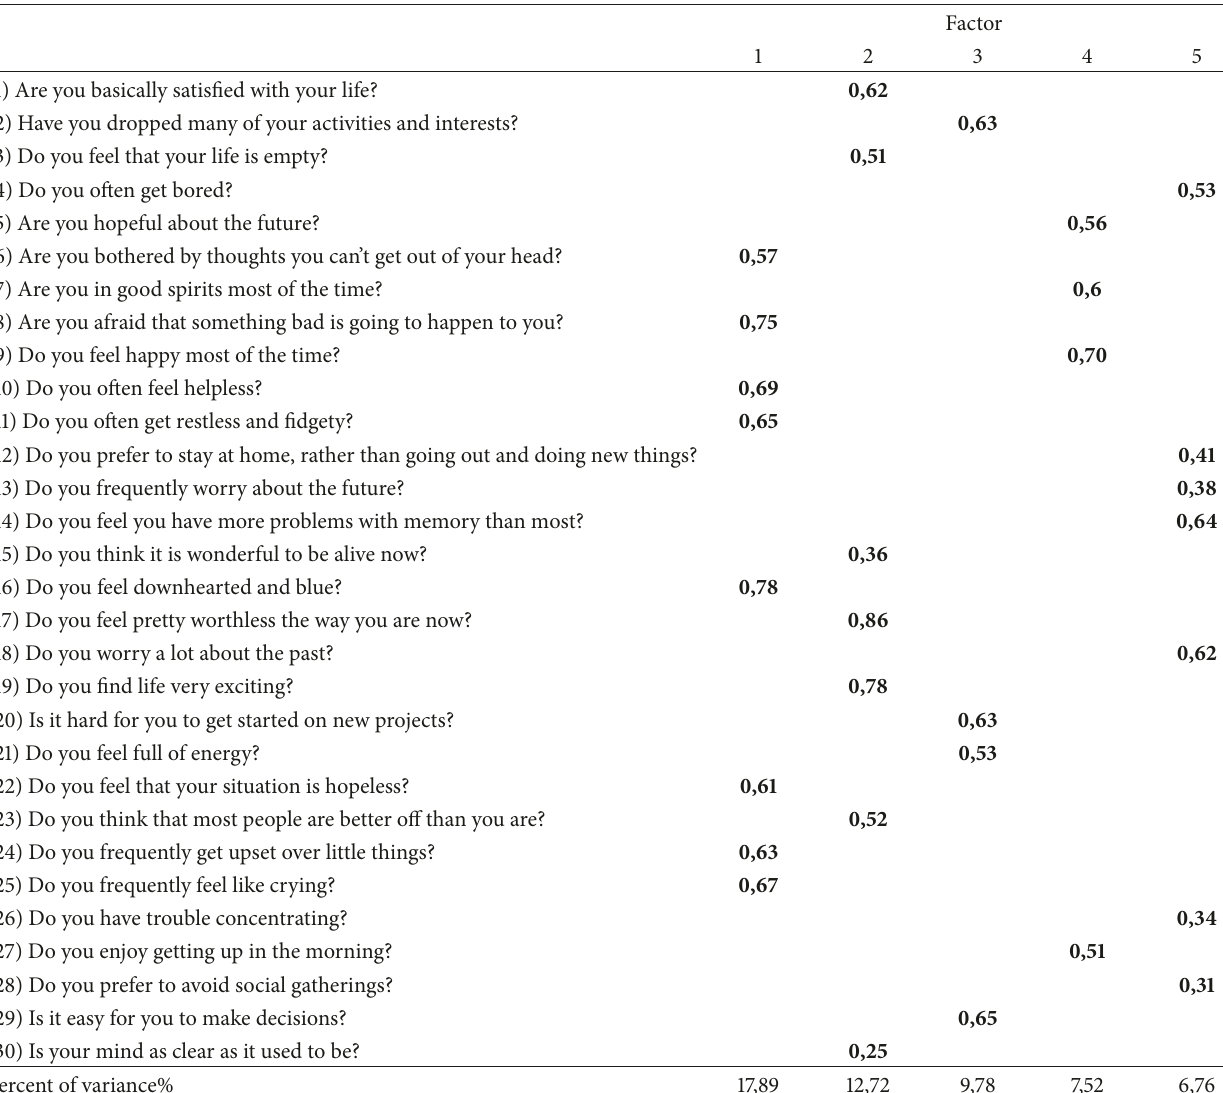
Table 4: Factorial